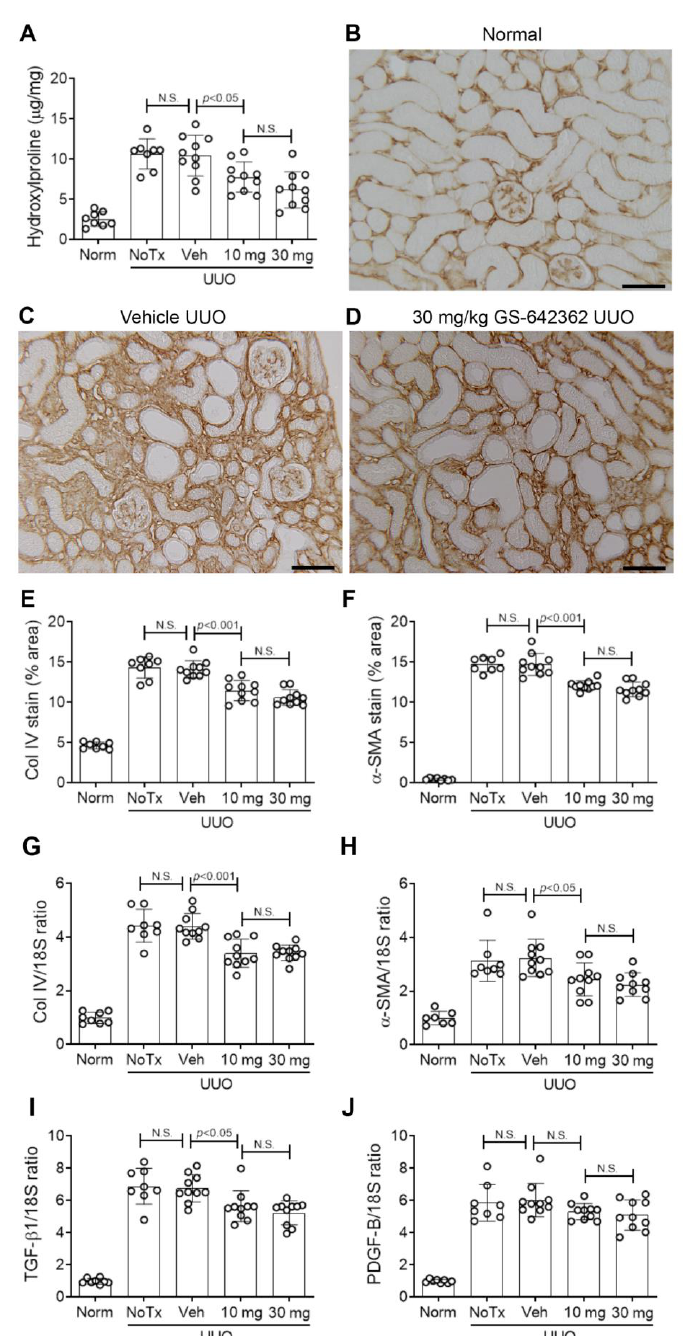
Figure 8. Renal fibrosis in the day 7 unilateral ureteric obstruction (UUO) model (n = 8 to 10/group). ( A ) Hydroxyproline assay of total collagen content. ( B – D ) Immunostaining for collagen IV. ( B ) Nor- mal kidney shows fine staining of collagen IV in the glomerular and tubular basement membranes. ( C ) Vehicle-treated UUO shows a substantial increase in interstitial collagen IV staining. ( D ) UUO treated with 30 mg/kg GS-642362 shows a partial in interstitial collagen IV staining. Bar = 100 µ m. ( E ) Graph of the area of interstitial collagen IV staining. ( F) Graph of the area of interstitial staining for α -SMA. RT-PCR for mRNA levels of ( G ) collagen IV, ( H ) α -SMA/Acta2, ( I ) TGF- β 1, and (J ) PDGF-B. N.S., not